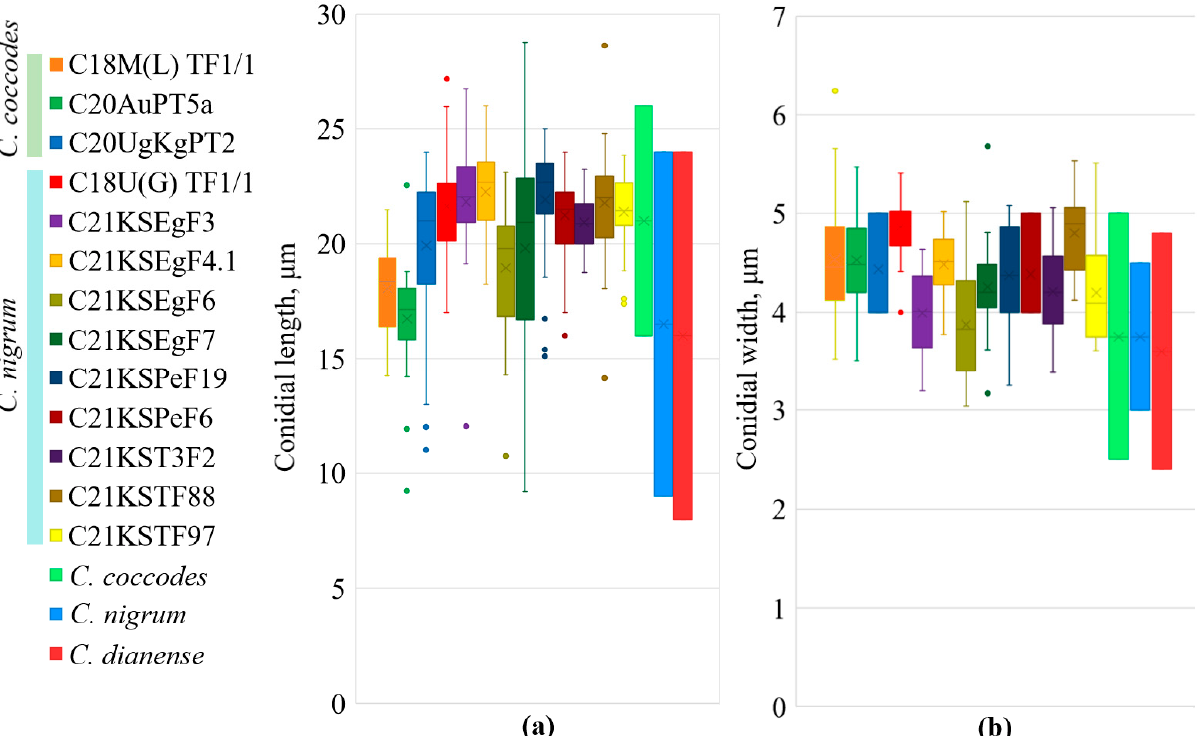
Figure 8. Comparison of the conidial lengths ( a ) and widths ( b ) of Colletotrichum isolates and type strains. Boxes indicate quartiles (first and third), whiskers indicate the minimum and the maximum values, and points outside the boundary are outliers.